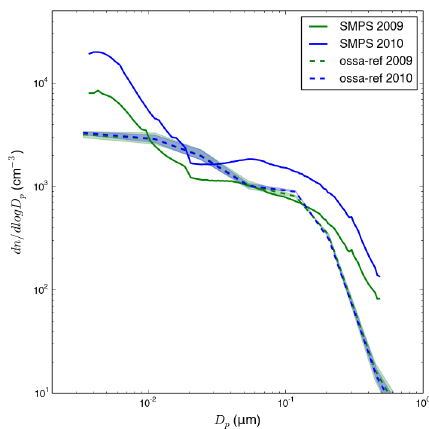
Figure 6. Annual mean measured and modelled size distribution at Mace Head. The modelled values are for the references simulation ossa-ref (solid line) and the spread is given by the sensitivity simu- lations